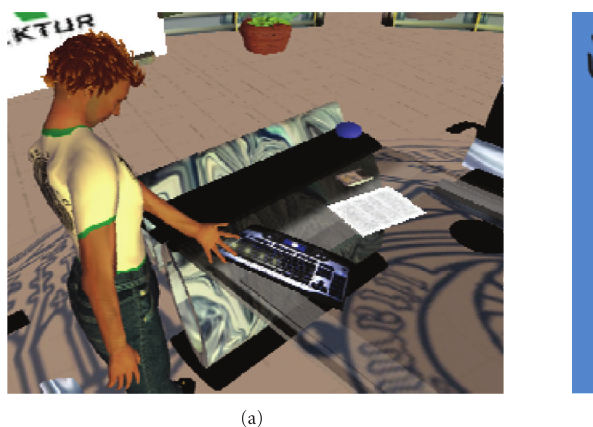
transmit it to the virtual world. This does not require much e ff ort. Nevertheless, we found these interaction possibilities insu ffi